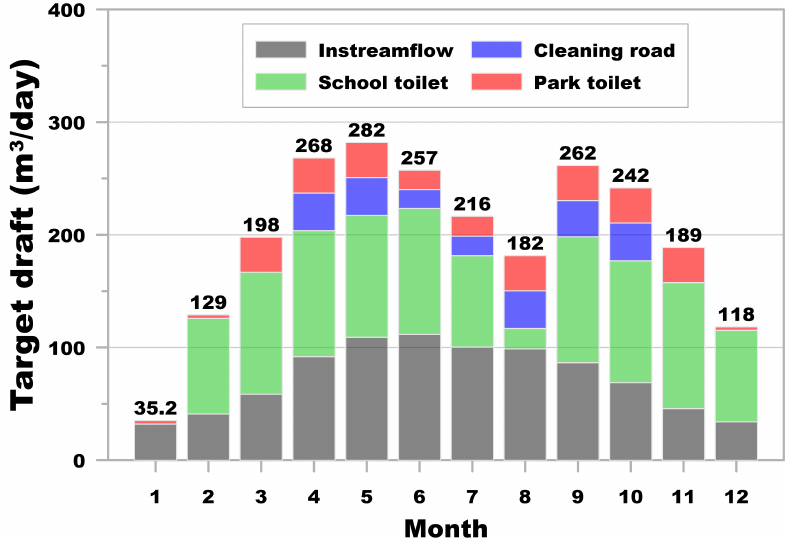
Figure 3. Monthly target draft of the rainwater harvesting system in the study